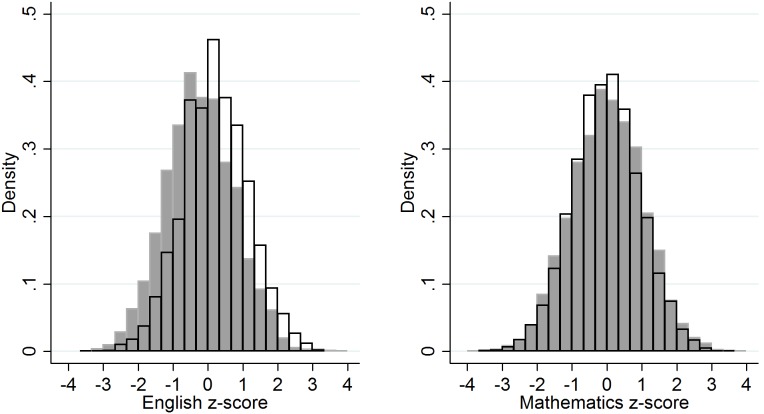
Overlay histograms showing z-scores for English and mathematics stratified by sex within the ALSPAC study.Boys’ results in grey; girls’ results in white. Girls exhibit an average 0.433 SD (95%CI 0.395, 0.470), p<10−10 advantage over boys in English, and attain more similar exam results in mathematics with boys exhibiting an average 0.042 SD (95%CI 0.004, 0.080), p = 0.0303 advantage over girls in mathematics.